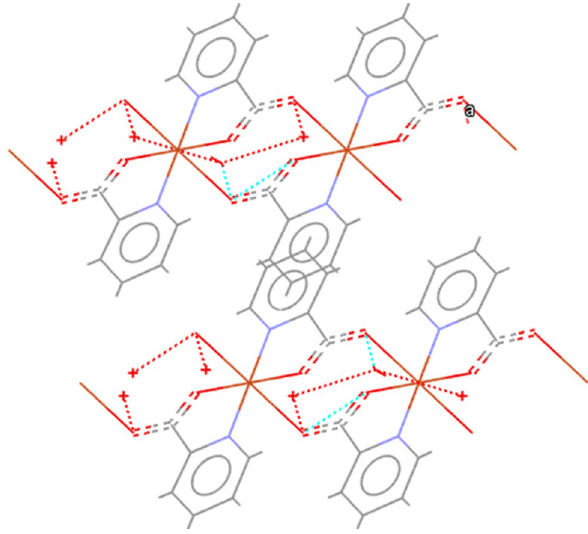
Fig. 3 Hydrogen bonding in compound